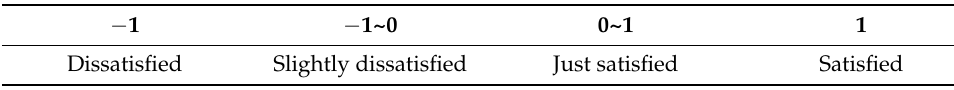
Table 3. Thermal satisfaction voting questionnaire.